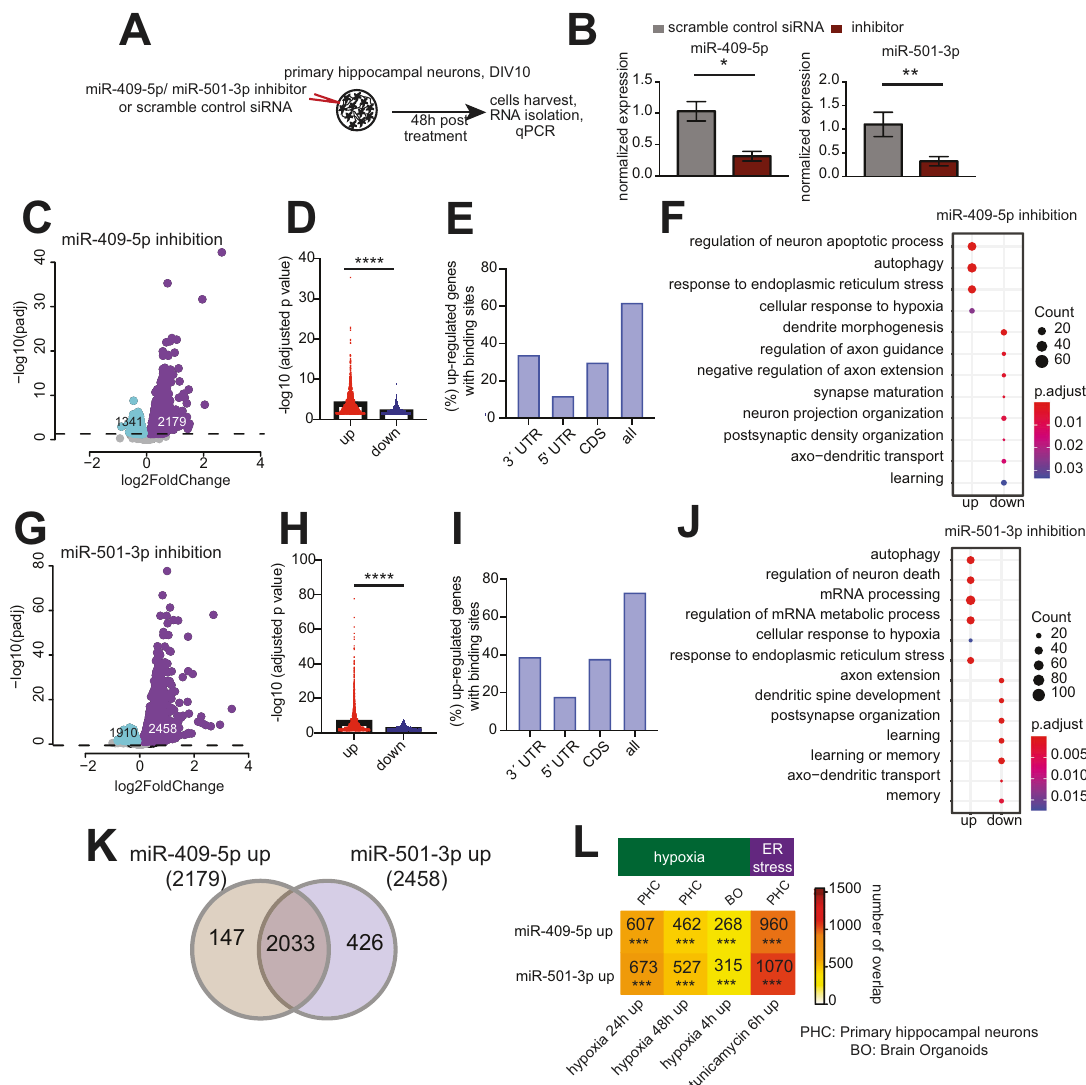
Fig. 4 Inhibition of microRNA-409-5p and microRNA-501-3p affect gene-expression programs linked to neuronal integrity. A Experimental design. Primary hippocampal neurons were cultured for 10 days. Cells were then incubated with lipid nanoparticles (LNPs) containing anti-miRs or scramble control RNA for 48 h before RNA was isolated for sequencing. B Bar graphs showing the quanti fi cation of microRNA-409-5p and microRNA-501-3p expression by qPCR. n = 6/group, unpaired two-tailed t test. Error bar indicates mean ± SEM. C Volcano plot representing differentially expressed genes upon microRNA-409-5p knockdown. The x -axis displays fold changes (log2), blue represents downregulation, red represents upregulation of genes after anti-microRNA-409-5p treatment. The y -axis shows an adjusted p value ( − log10). FDR < 0.05. D Barplot showing comparison of FDR adjusted p value distribution between up- and downregulated genes after silencing of microRNA-409-5p. **** p < 0.0001, Wilcoxon – Mann – Whitney test, two-tailed test, unpaired. Error bar = mean ± SEM. E Percentage of the up-regulated genes overlapped with the genes having predicted microRNA-409-5p binding sites at 3 ′ UTR, 5 ′ UTR, coding sequence (CDS) and all three combined (all). Genome-wide predicted microRNA binding sites were retrieved from miRWalk (version 3). F Gene ontology analysis of the deregulated genes. Dots on the left and represent up- and downregulated processes respectively. The size of the dots represents the number of genes belonging to each process. Color intensity represents adjusted p value. G Volcano plot representing differentially expressed genes upon microRNA-501-3p knockdown. H Barplot displays FDR adjusted p value distribution from up- and downregulated genes after microRNA-501-3p knockdown. **** p < 0.0001, Wilcoxon – Mann – Whitney test, two-tailed test, unpaired. Error bar = mean ± SEM. I Percentage of the microRNA-501-3p inhibition induced upregulated genes overlapped with the genes having predicted microRNA binding sites at 3 ′ UTR, 5 ′ UTR, coding sequence (CDS), and all three combined (all). Genome-wide predicted microRNA binding sites were retrieved from miRWalk (version 3). J Dot plot representing the deregulated gene ontology biological processes. K Overlap between up-regulated genes from microRNA-409-5p and microRNA-501-3p inhibition experiments. L Hypergeometric overlap of the deregulated genes to those from hypoxia and ER stress responses in neurons. Fisher ’ s exact test, adjusted p value with Benjamini Hochberg (BH) correction. Color map represents the number of overlapping genes. PHC represents primary hippocampal neurons, BO represents Brain organoids. PHC data were retrieved from [25] and BO data were retrieved from ceiling effect could be excluded [22, 30, 31].Previous studies analyzed healthy human subjects. This view is supported by have analyzed circulating microRNAs in humans that underwent previous studies showing that aerobic exercise improved short exercise but most of these studies aimed to correlate microRNA term memory function and performance in the trial-making tests expression to other physiological parameters than cognitive when cognitively impaired individuals were analyzed, hence a